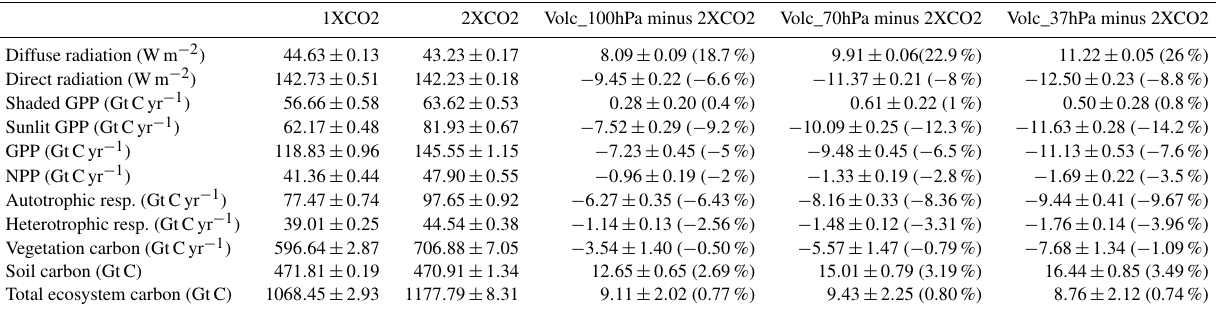
Table 2. Global and annual mean values of key land model variables from the 1XCO2 and 2XCO2 simulations and the change in these variables in the stratospheric sulfate experiments relative to the 2XCO2 experiment. Uncertainties for changes are estimated as 2 standard errors calculated from 60 annual mean differences. Uncertainties for 1XCO2 and 2XCO2 cases are estimated as the standard deviation from the 60 annual means. Percentage changes from the 2XCO2 simulation is given in